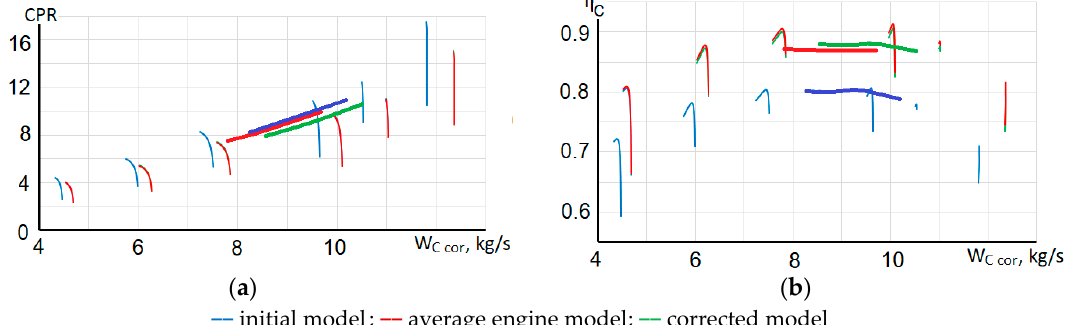
Figure 9. Compressor maps with the operating lines.